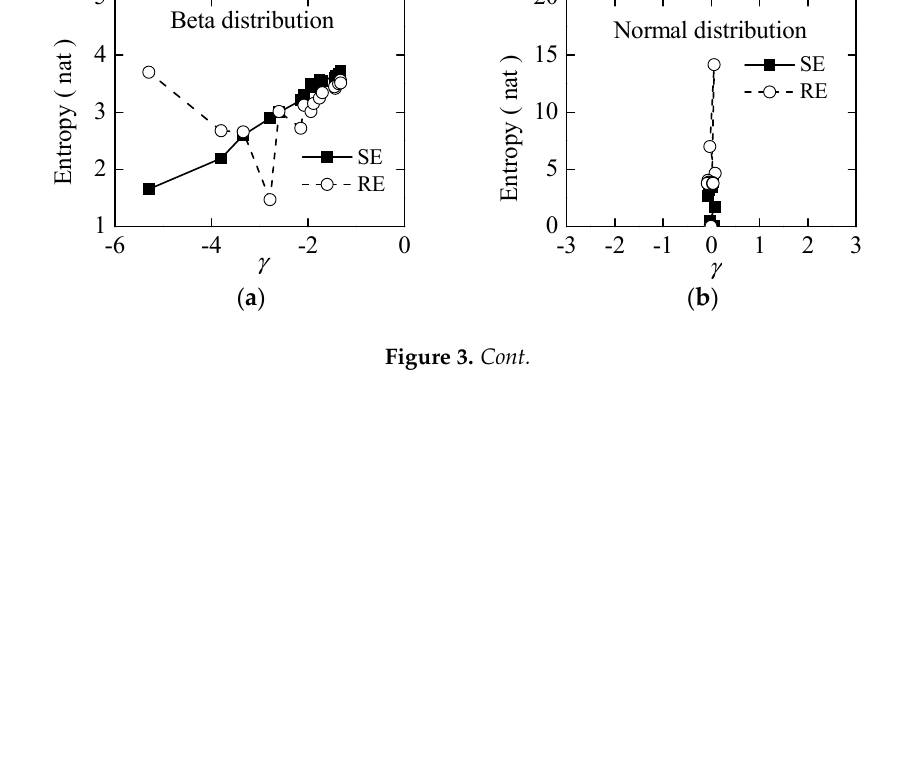
Figure 2. Seven typical probability distributions. Case n ( n = 1, 2, 4, 7, 13, and 15) corresponds to the case in Table 1.